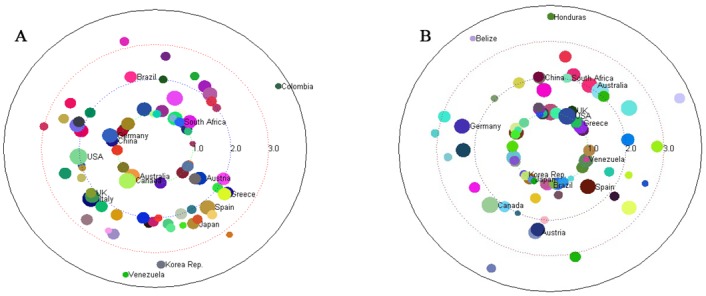
Trading trophic levels of countries for the commodity of live bovine animals from different viewpoints.(A) The viewpoint of commodity flow. (B) The viewpoint of money flow. Country nodes are plotted in a circle, whose distances to the center of the circle are proportional to their trophic levels, and whose angles and colors are selected randomly. The nodes sizes are in proportion to the natural logarithm of the nodes total outflow.